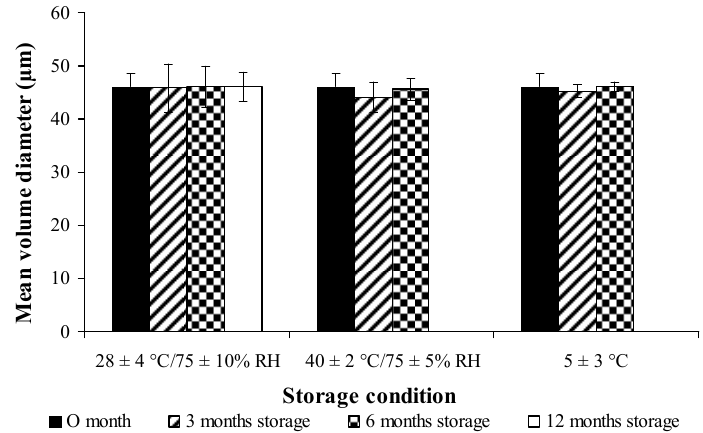
Figure 11. Stability studies of cross-linked curcuminoids microcapsule lyophilized powder on particle size at different conditions.